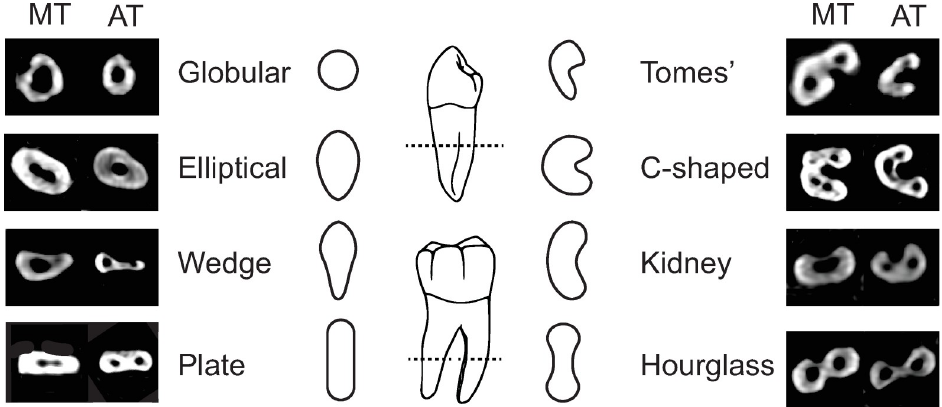
Fig 12. External root morphologies. Left and right columns = axial CT slices showing external root morphologies at the middle third (MT) and apical third (AT). Centre illustrations = root morphologies at centre of